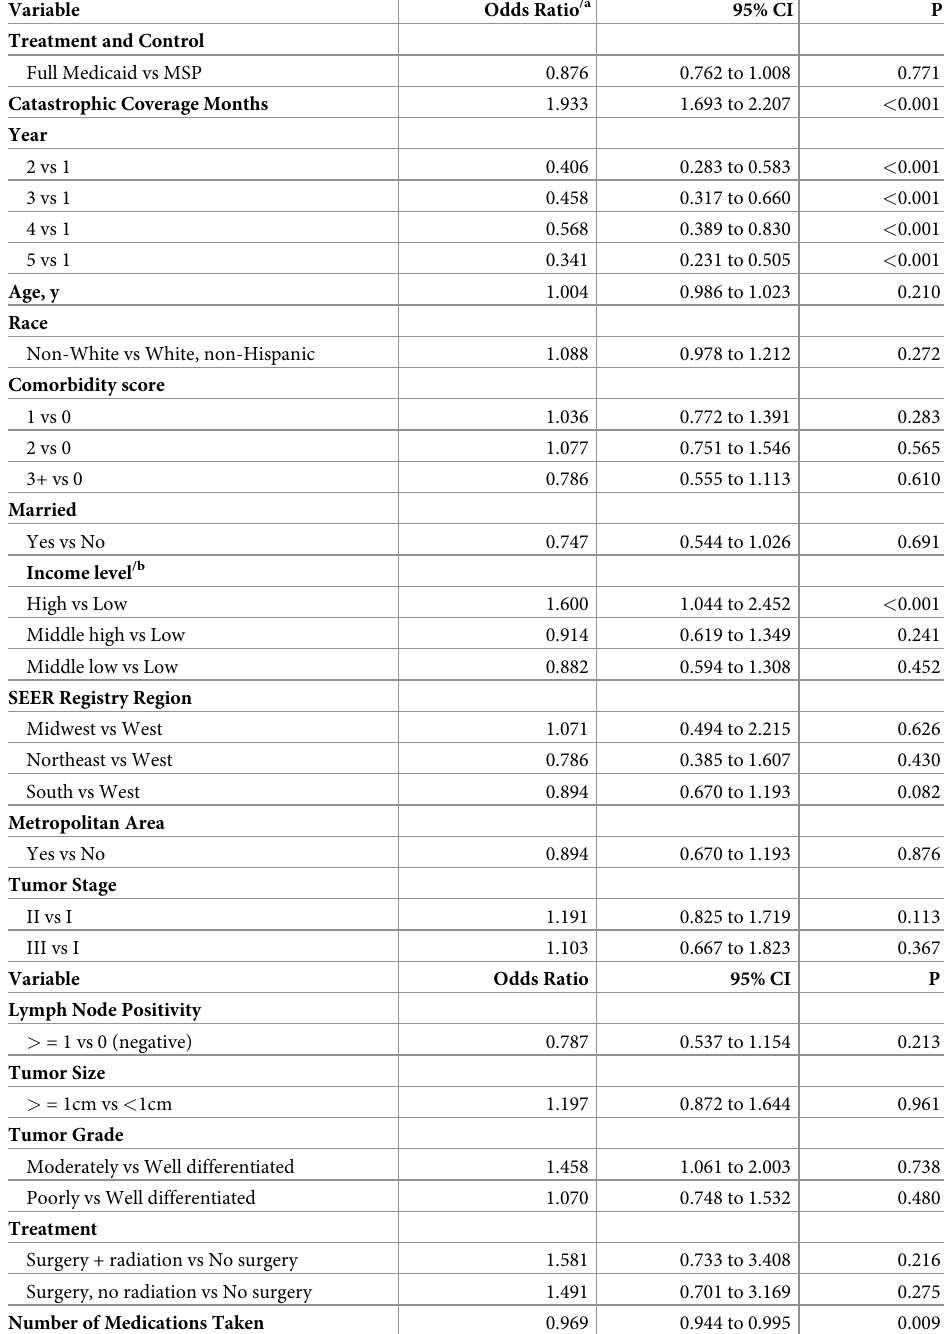
Table 2. Model-based adjusted odds ratio of predictors for aromatase inhibitor adherence measured by medica- tion possession ratio (MPR) > = 80% among Medicare and Medicaid dual eligible beneficiaries diagnosed with hormone receptor-positive early stage breast cancer from 2007 to